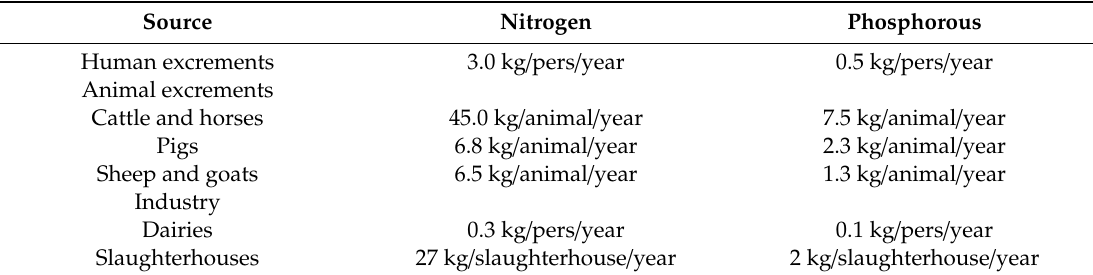
Table 3. Estimated intial emission of nutrients from humans, animals and industry in 1900, based on values reported in current literature reduced by 25% to account for di ff erences in nutrition and animal